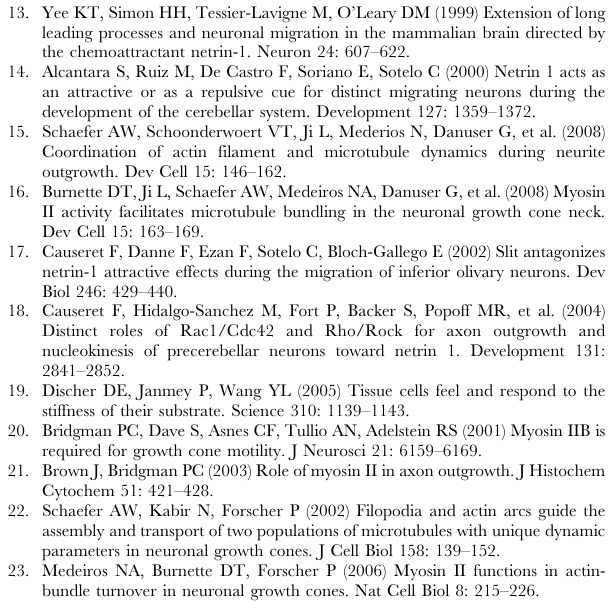
Figure S4 Analysis of the effect of increasing concentrations of Rac1 inhibitor on leading process outgrowth and nuclear migration- E12.5 wt rhombic lip explants were cultured in collagen matrix in presence of a range of concentrations of Rac1 inhibitor : 0 mM (A), 2 mM (B), 5 mM (C), 10 mM (D). Axon outgrowth and nuclear migration was then analyzed after anti-total a-tubulin and DAPI immunostainings. Quantifications were ob- tained using the threshold technique and Metamorph analysis (E). No significant difference could be observed between control condition (n=12) and 2 mM Rac1 inhibitor treated explants (n=18), neither for leading process outgrowth nor for nucleokinesis. (C) At 5 mM of Rac1 inhibitor, the outgrowth was significantly decreased but nuclear migration was not affected (n=18). (D) At the highest concentration, 10 mM, both axon outgrowth and nuclear migration were significantly impaired compared to control condi- tions (n=18). ** P , 0,001. Scale bar : 500 m